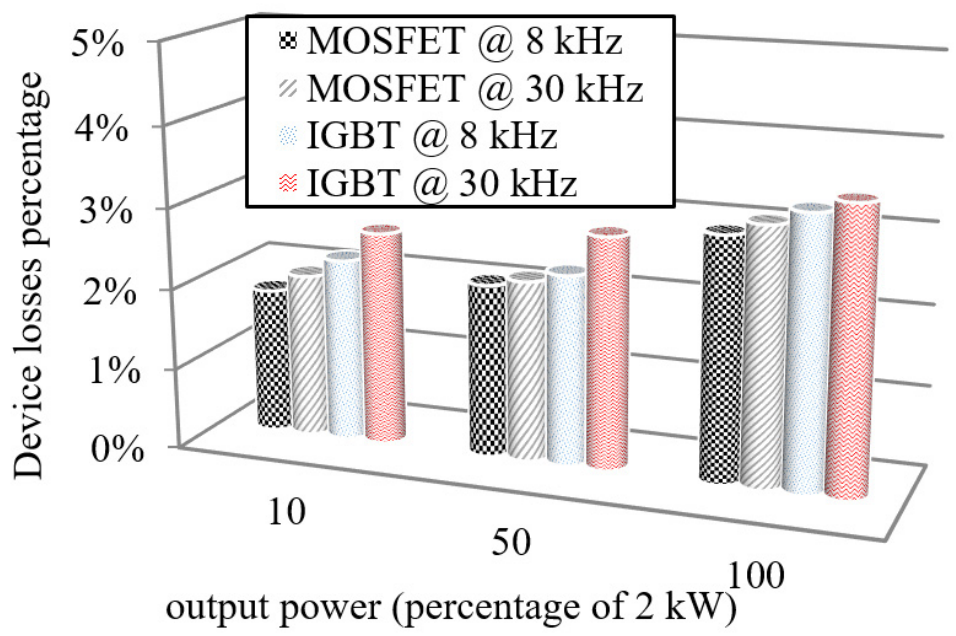
Figure 15. Percentage of device power loss in terms of output